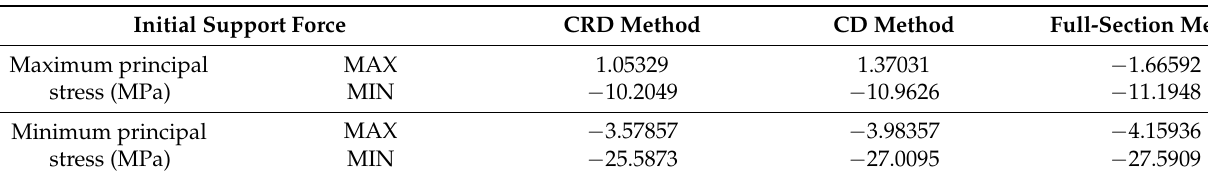
Table 4. Initial support force.